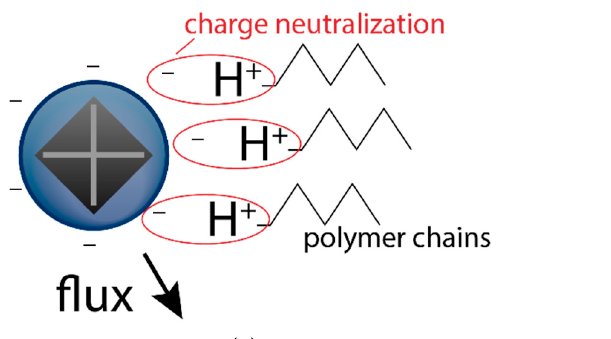
( b ) Figure 3. ( a ) Magnetic response of free MENs vs. polymer-coated MENs; ( b ) influence of MEN dop- ing on the magnetic signal on a polymer adhesive. The sensing capability of MENs predominantly comes from variations in the surface charge density based on the loading history [24]. For the uncoated and coated individual